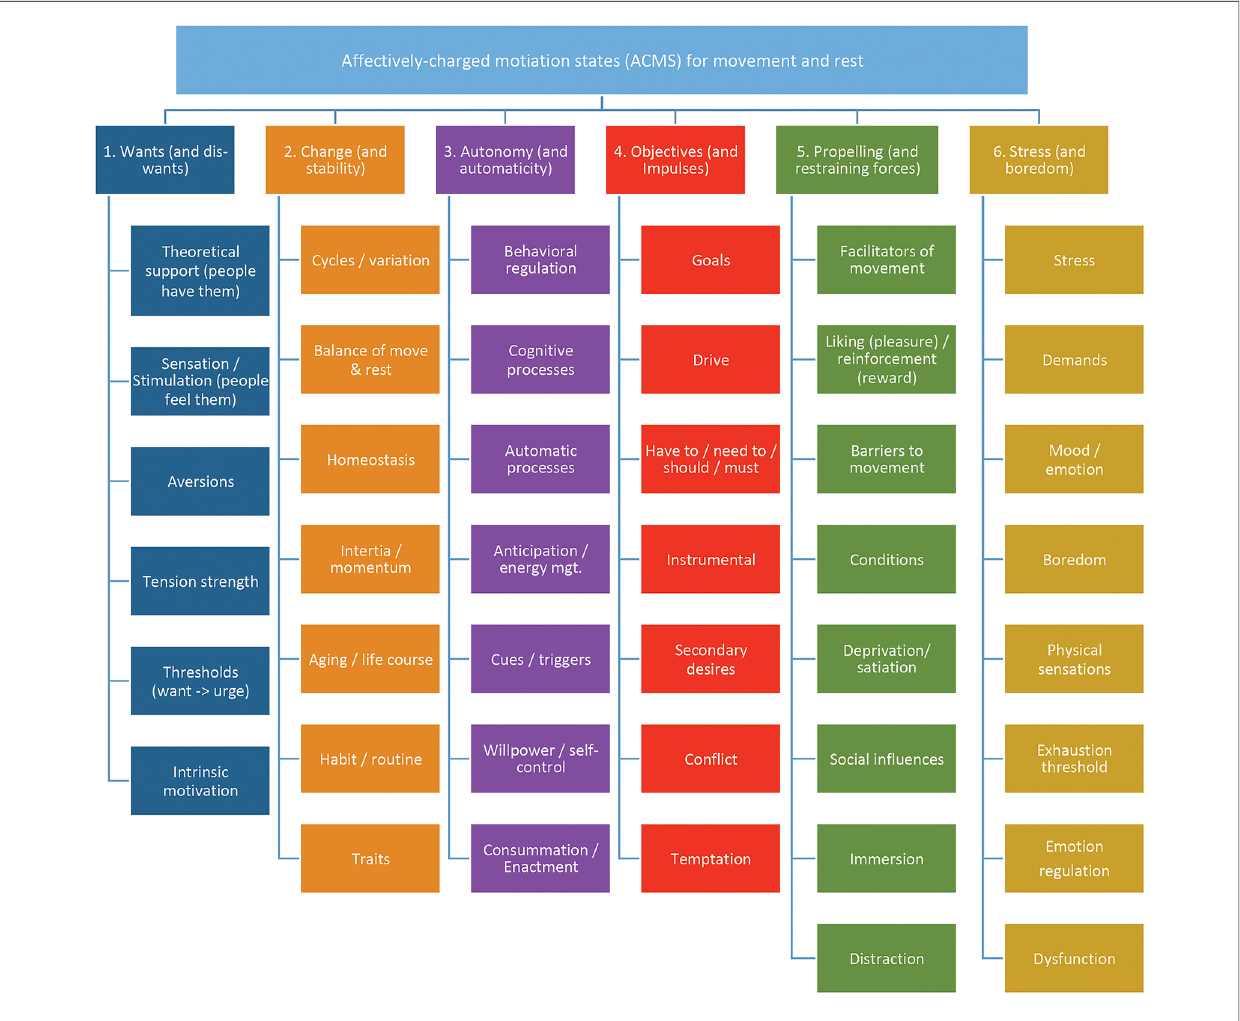
FIGURE 2 Final model of the 43 higher order themes (HOTs) categorized into six super higher order themes